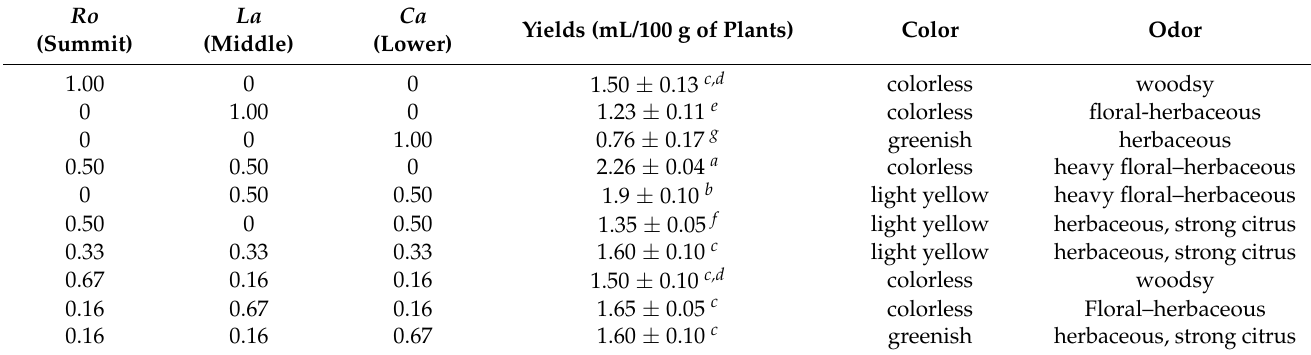
Figure 1. Simultaneous hydrodistillation–steam distillation apparatus, as described in [24]. Table 1. Essential oil yields obtained from the simultaneous hydrodistillation–steam distillation.